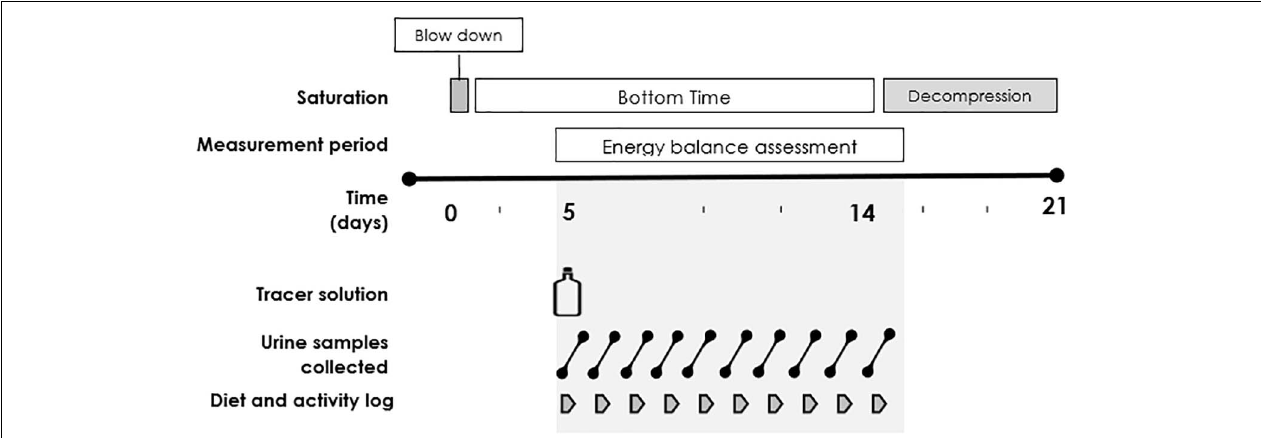
FIGURE 1 | Outline of the study